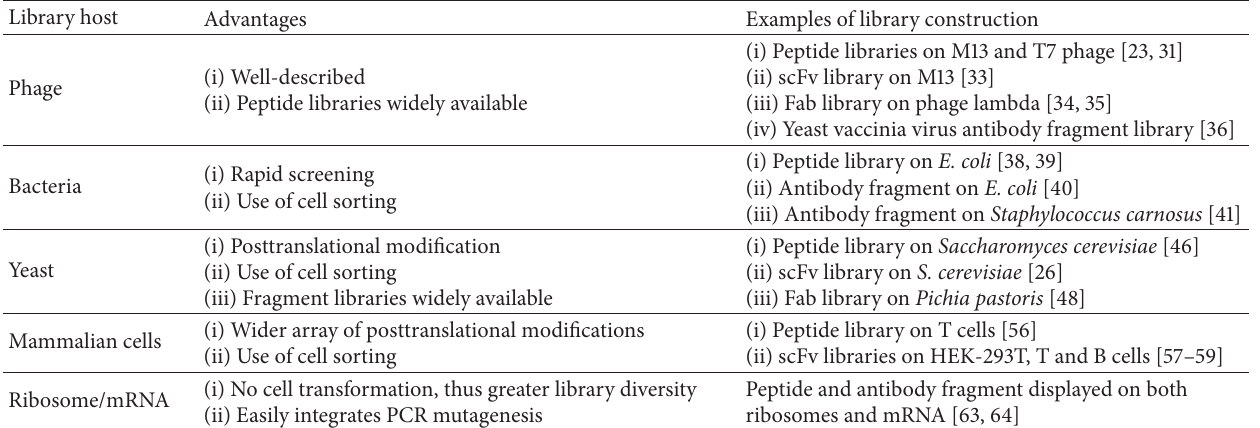
Table 2: The most common types of library display